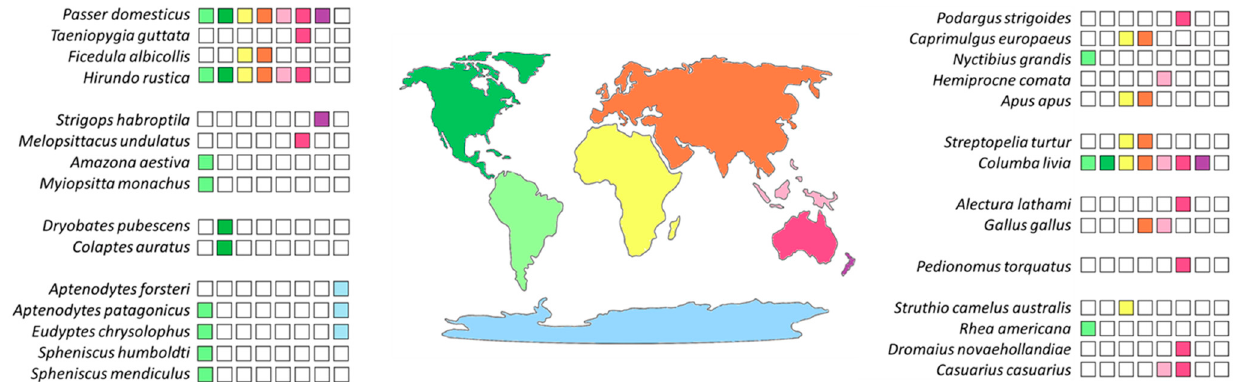
Figure 1. Species considered in this study and their geographical distribution are shown. The landmasses are colored as follow: North and Central America in dark green; South America in light green; Africa in yellow; Antarctica in blue; Europe-Asia in orange; Australia in magenta; Indonesia and New Guinea in pink; New Zealand in purple. The colored square boxes indicate the geographical distribution of each species analyzed in this study.